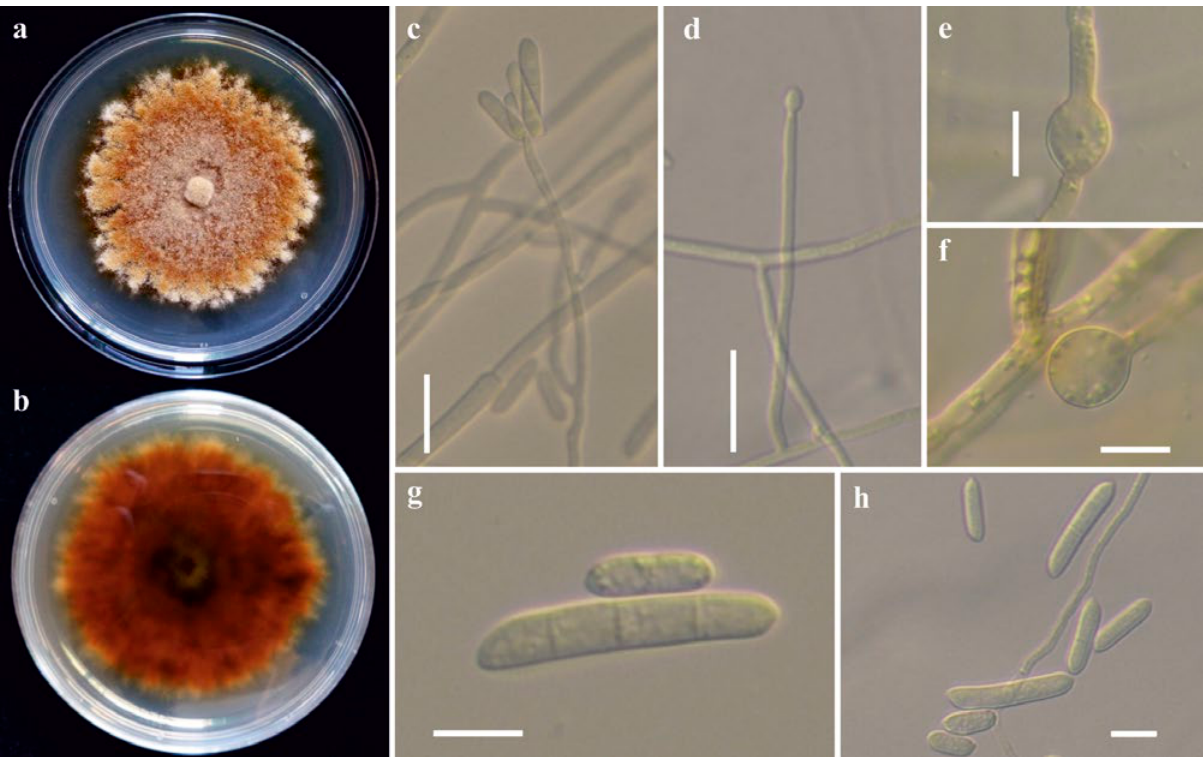
Figure 4. Dactylonectria hordeicola. (a-b): upper and lower sides of 20-d-old colony on PDA plate at 24ºC. (c-d): conidiophores and phialides (bars =20 μm). (e-f): chlamydospores (bar = 10 μm). (g-h): microconidia and macroconidia (bar = 10